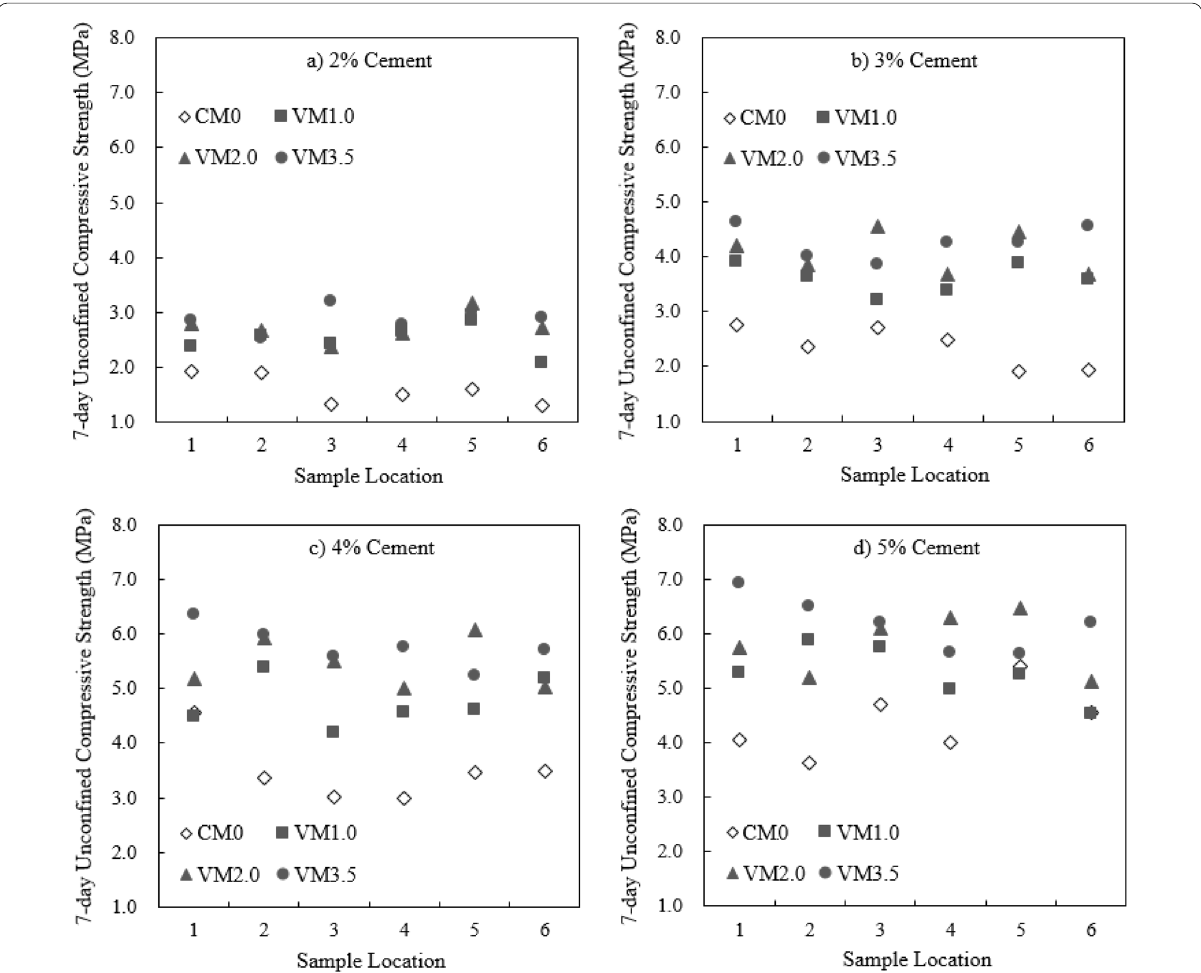
Fig. 12 7-day UCS of CSM samples from different locations (see Fig. 3d): a 2% cement dosage; b 3% cement dosage; c 4% cement dosage; (5) 5% cement